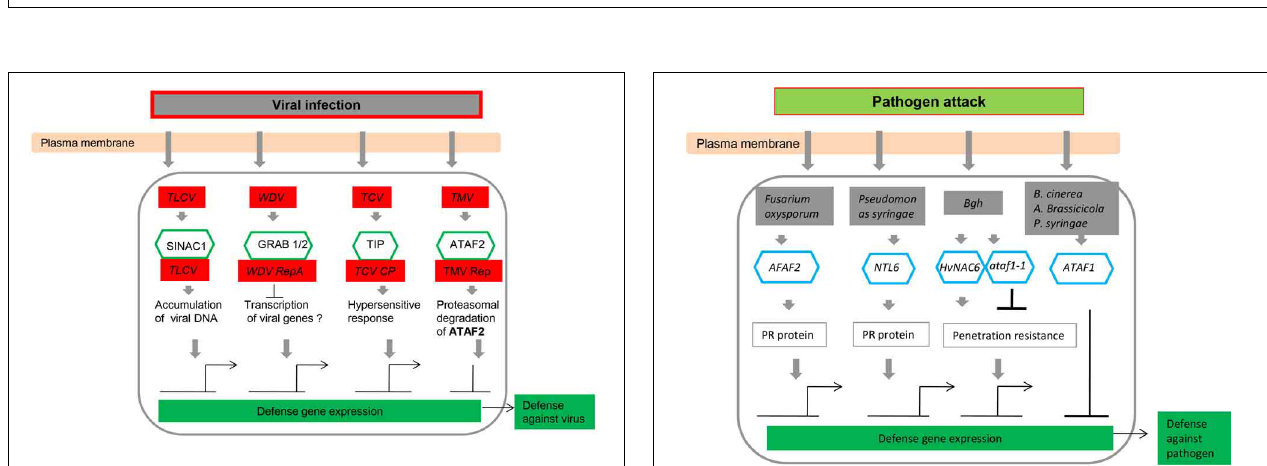
FIGURE 2 | Conserved motifs outside of the NAC domain of the SNAC/(IX) group in rice and Arabidopsis.